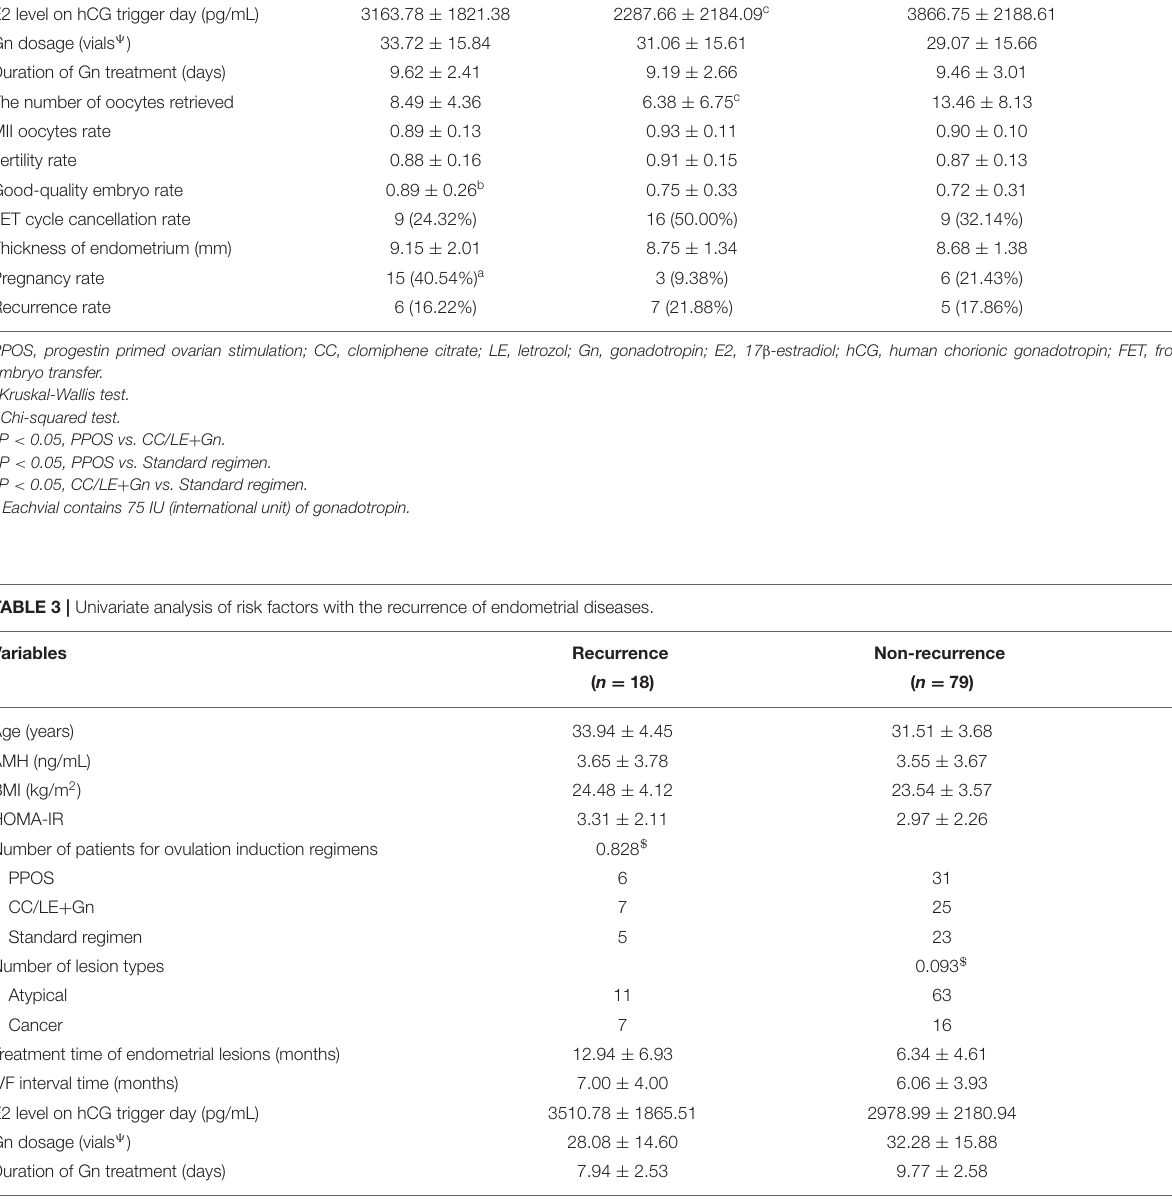
TABLE 2 | Stimulation characteristics and outcomes for each ovulation induction treatment group. Characteristic PPOS ( n = 37)